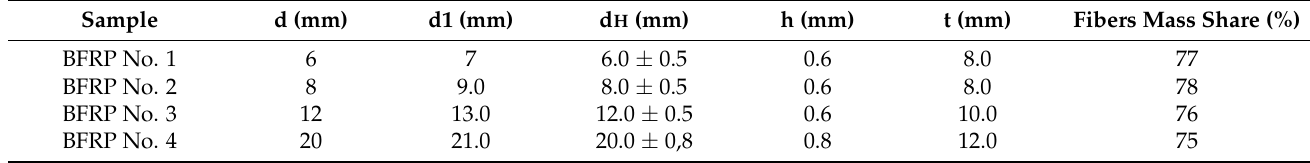
Table 1. Technological modes of forming the periodic profile of the rebar.